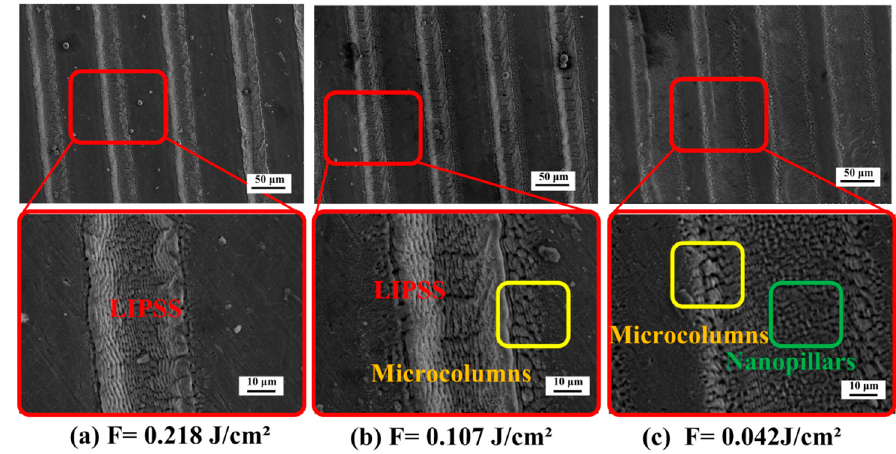
Figure 6. Effects of laser energy density on the morphology of LIPSS (scanning speed is 40 mm/s, the pulse frequency is 0.1 MHz, the single pulse energy is 75 µ J). The laser energy density is ( a ) F = 0.218 J/cm²; ( b ) F = 0.107 J/cm²; ( c ) F = 0.042 J/cm².